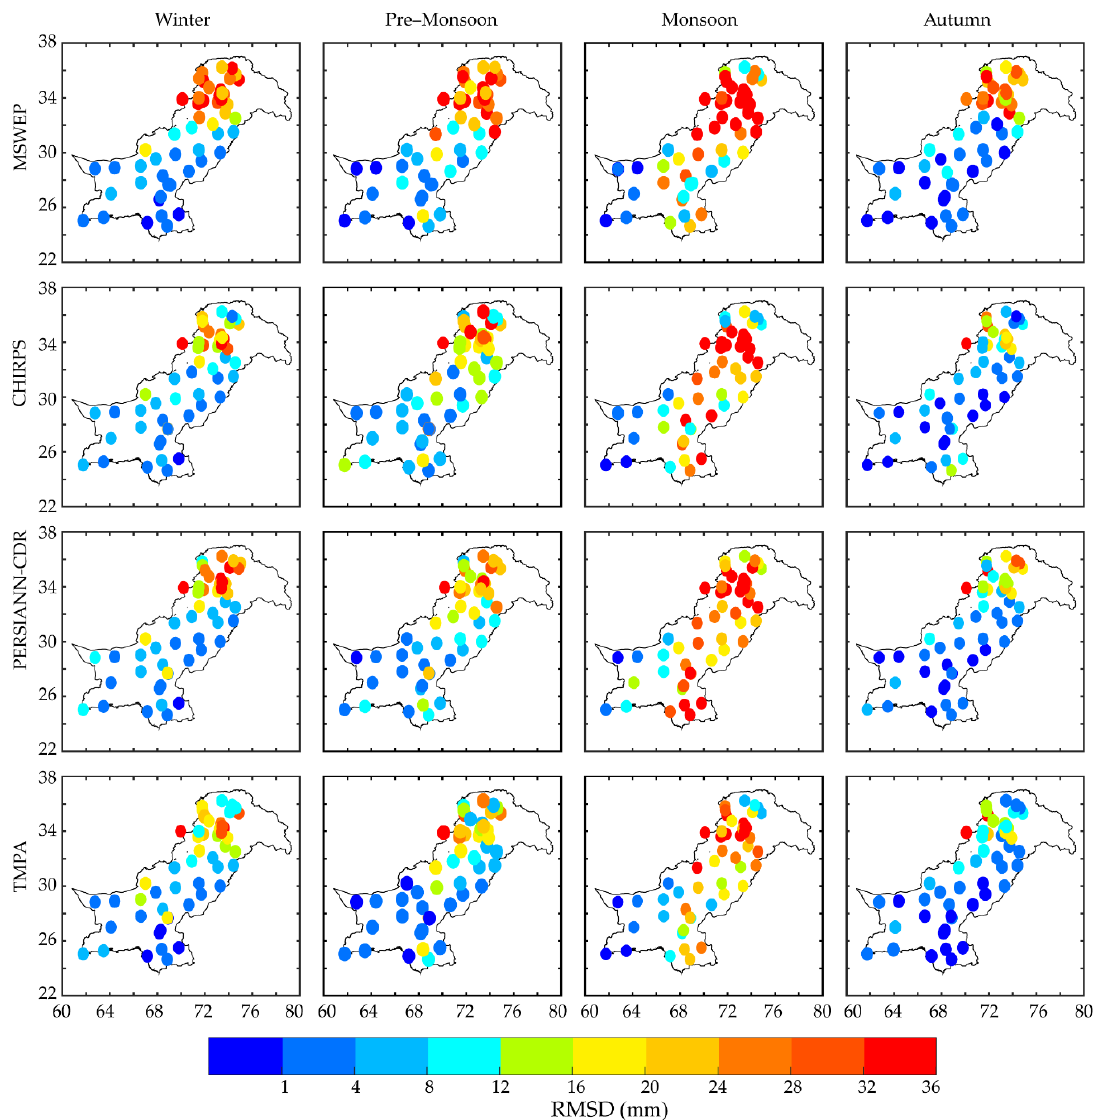
Figure 9. Root mean-square difference (mm) of interannual precipitation for in-situ and GPPs in different seasons.